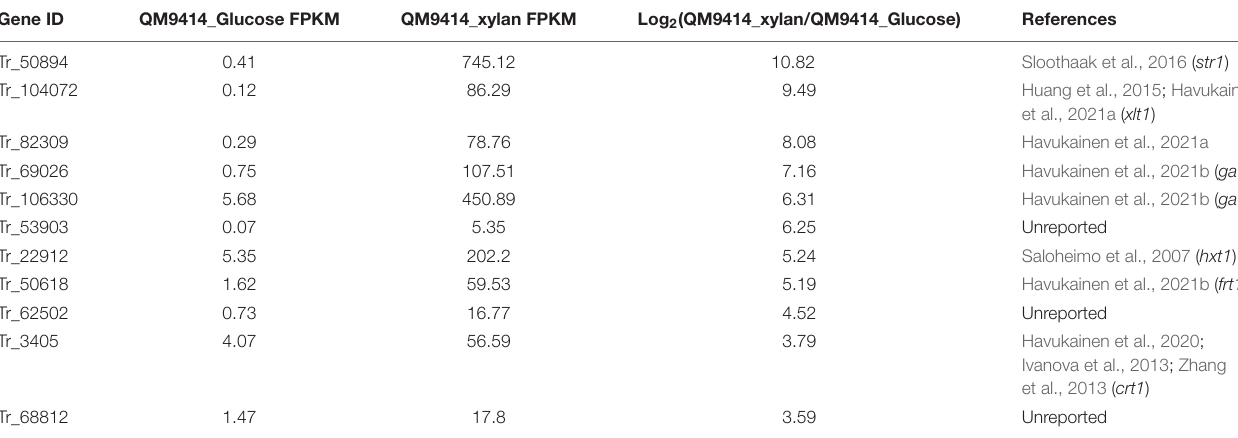
TABLE 2 | Putative sugar transporter encoding genes with significant induction on xylan in Trichoderma reesei